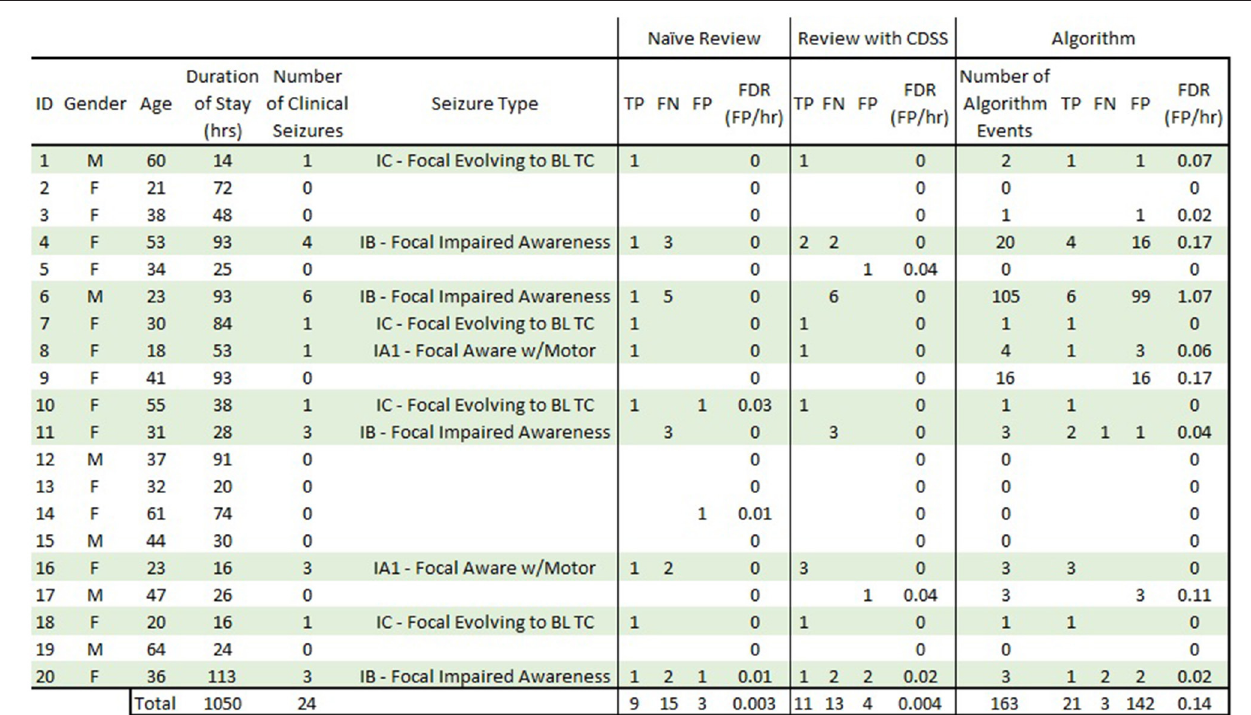
FIGURE 5 | Complete subject demographics and results. Subjects in light green are those that had focal-onset seizures during their EMU stay. “Naive Review” results are consensus epileptologist review of the REMI montage without algorithm-detection annotations. “Review with CDSS” results are consensus epileptologist review with algorithm-detection annotations. “Algorithm” results are for the REMI automated seizure detection algorithm. TP, true positive; FN, false negative; FP, false positive; FDR, false detection rate; BL TC, bilateral tonic-clonic.